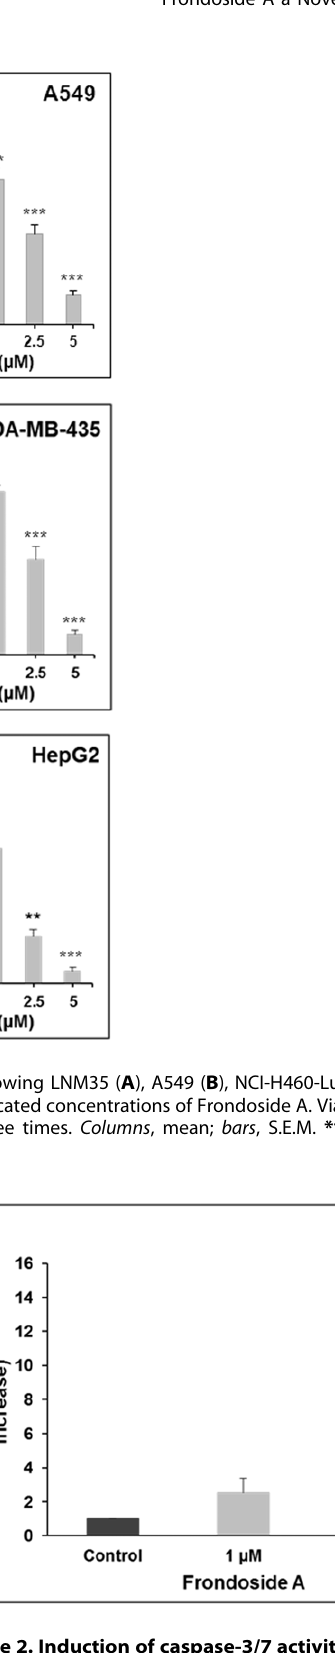
Figure 2. Induction of caspase-3/7 activity was analyzed in LNM35 cells treated for 24 h with Frondoside A (1–2.5 m M), normalized to the number of viable cells per well and expressed as fold induction compared with the control group. *Significantly different at P , 0.05.